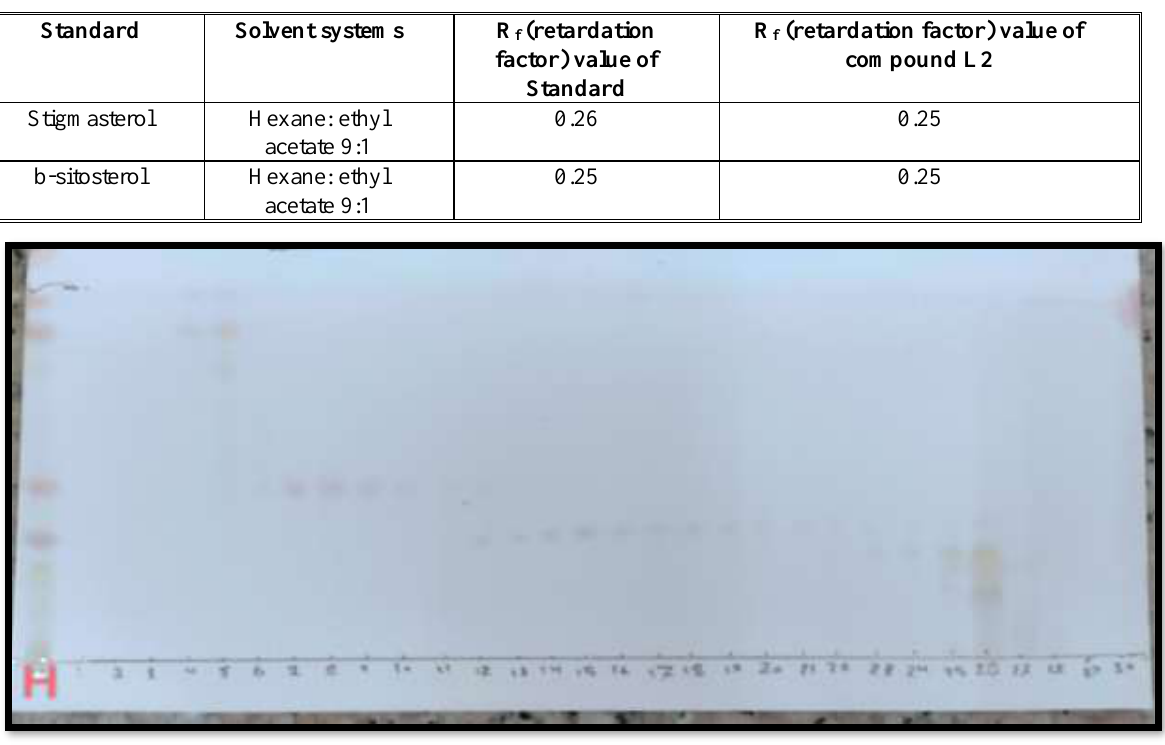
Figure 3 . Thin layer chromatogram for Hexane fraction (H)with fractions obtained by combi flash column chromatography after purification hexane fraction. Using silica gel GF 254nm as a stationary phase developed in (Hexane: acetone 8:2 ) as mobile phase. Visualized by 5% H2SO4 spray reagent followed by heating for 5-10 minutes at 110 C°